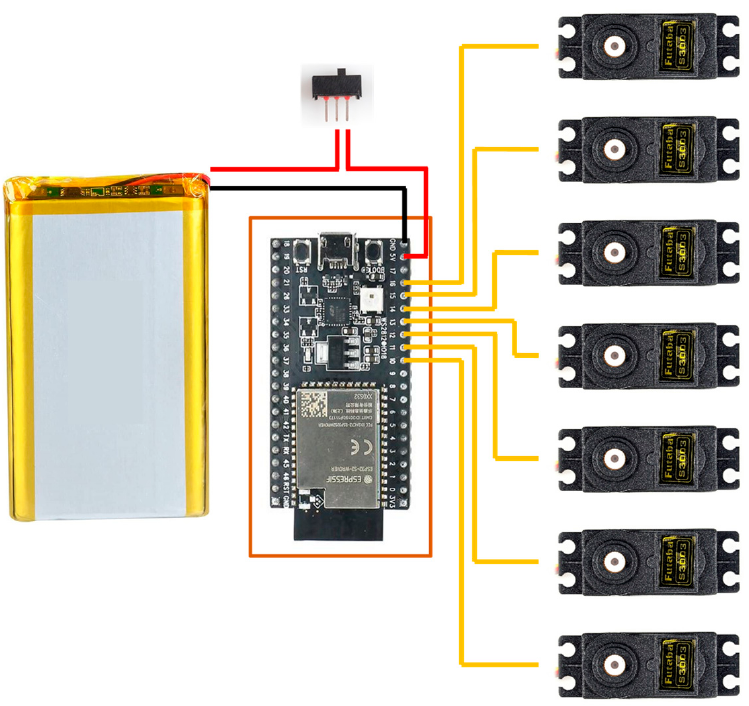
Figure 8. Schematic representation of the electronic design.